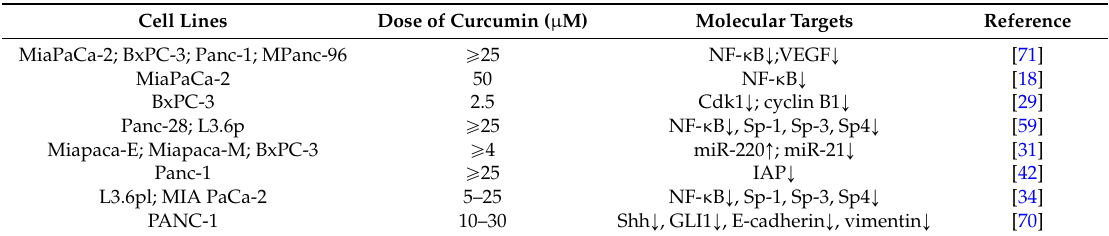
Table 1. A summary of in vitro studies on the role of curcumin in Pancreatic Cancer cell growth. Cell